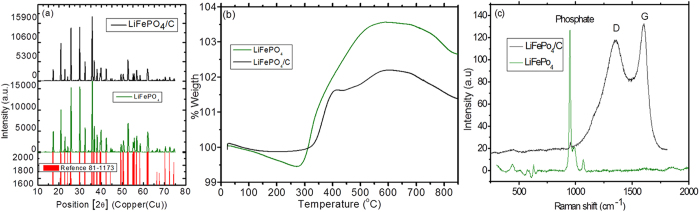
(a) XRD patterns of pristine LiFePO4 and LiFePO4/C samples, (b) TGA curves of LiFePO4 and LiFePO4/C, (c) Raman spectrum of the LiFePO4/C.